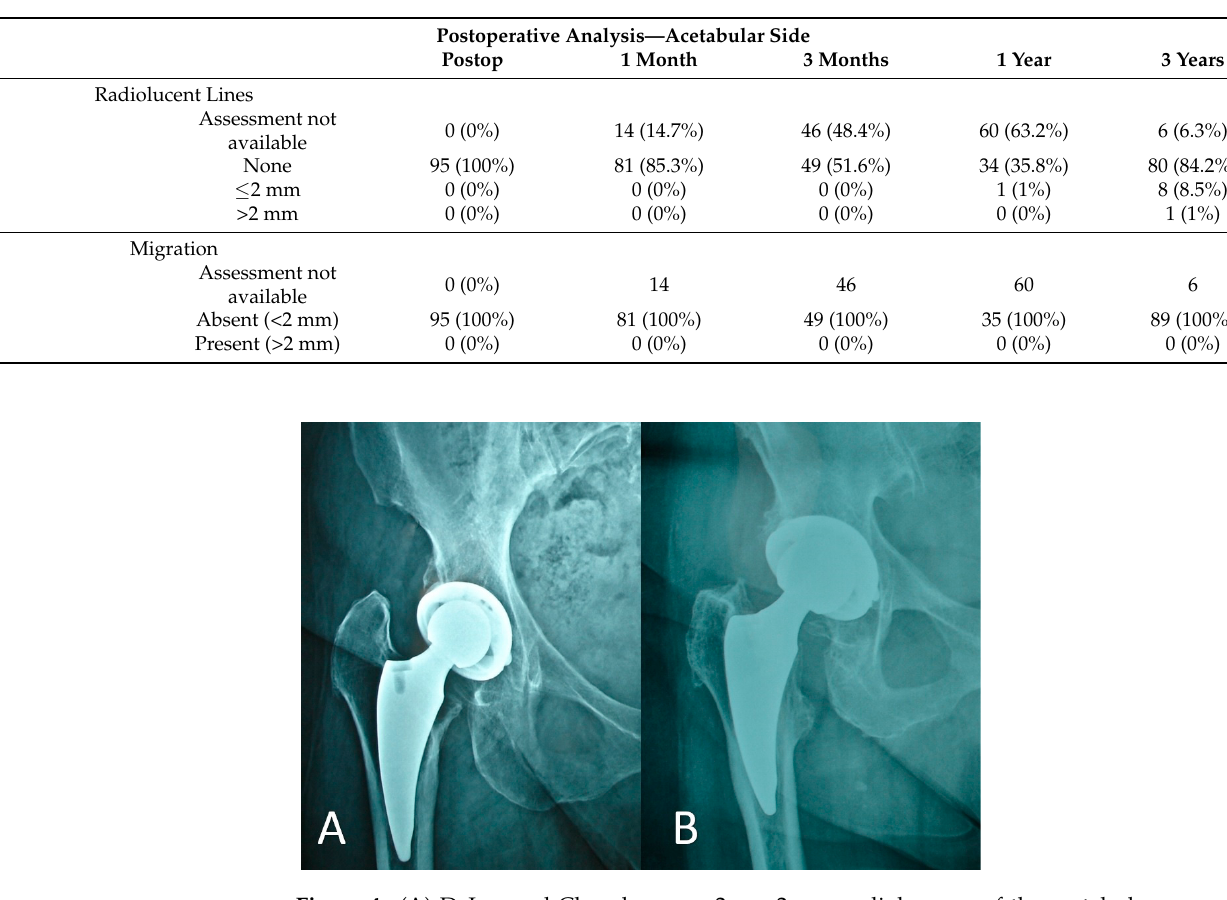
Table 4. Radiographic analysis of the DELTA ST-C cup during the follow-up period.